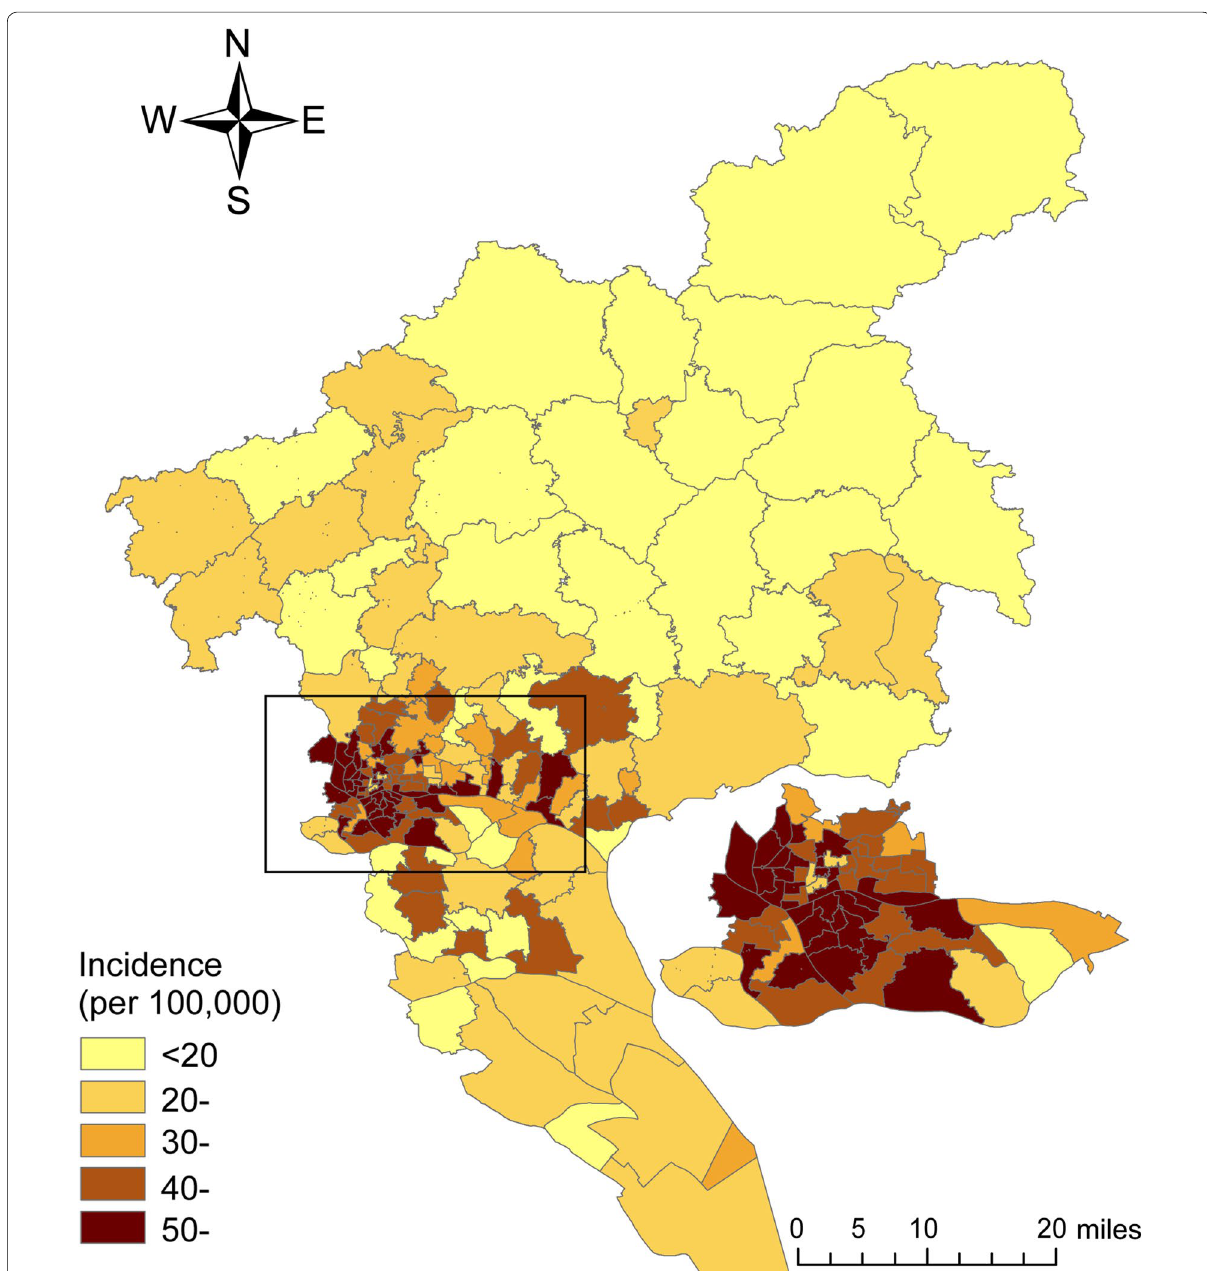
Fig. 1 Geographic distribution of colorectal cancer incidence in Guangzhou, China during 2010–2014. The incidences of colorectal cancer in cen‑ tral urban areas are higher than those in surrounding suburban